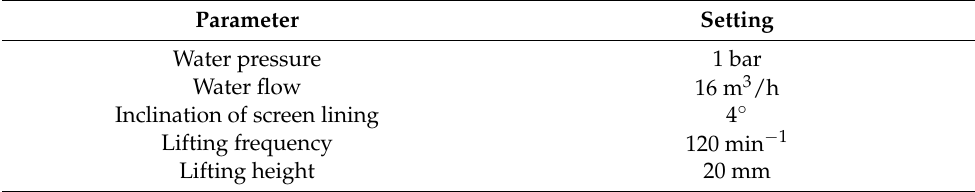
Table 9. Operating parameters of the jig.